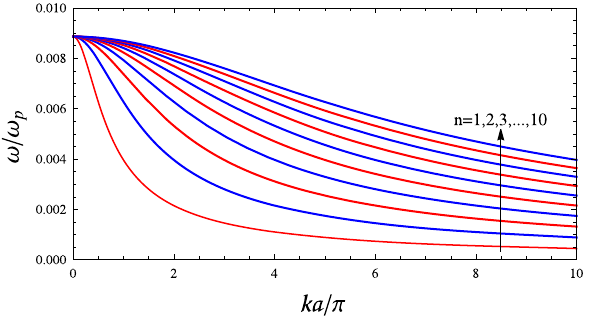
Figure 2. Dispersion curves of the first ten bulk electrostatic modes of a planar slab of nanowire-based HMMs 5 nm, d 1 µ m and PEC boundaries, using Eq. (10). The modes n with r = = 2, 4, 6, 8 are odd (anti-symmetric) modes. The slope of curves is negative in the frequency range modes and n = 0 < ω f ω p for all mode orders. Therefore, these modes called backward waves. For a backward wave, the − ≤ directions of group velocity (power flow) and phase velocity (phase propagation) are mutually (cid:31)